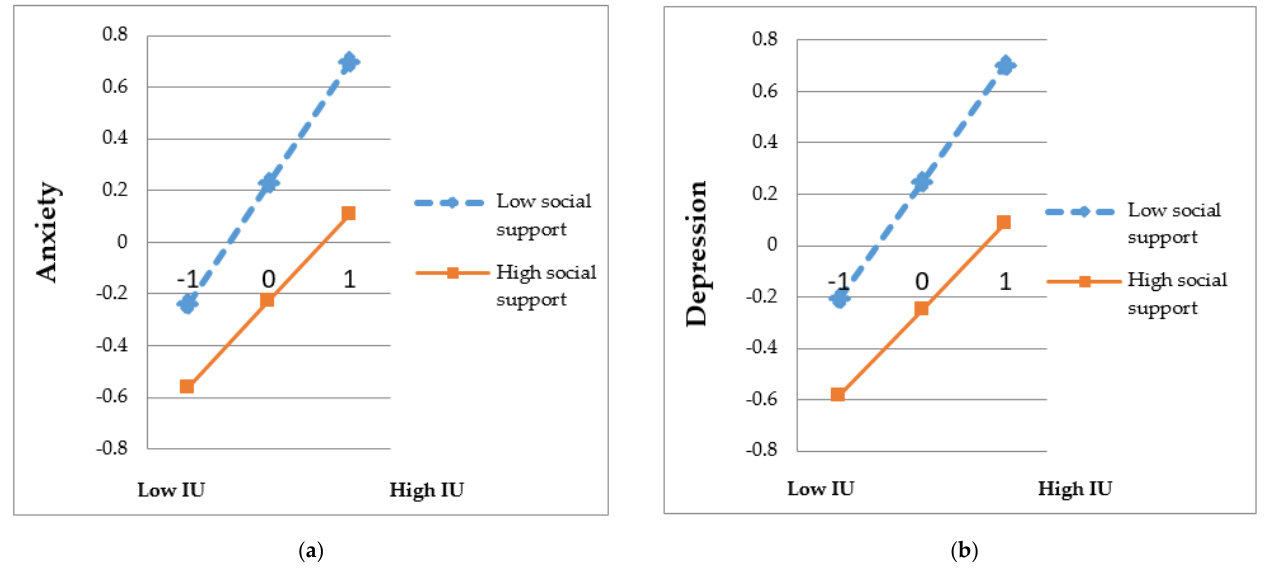
Figure 1. Moderation effect of social support between IU and mental health variables. IU, intolerance of uncertainty ( a ) Description of moderation effect of social support between IU and anxiety. ( b ) Description of moderation effect of social support between IU and depression.